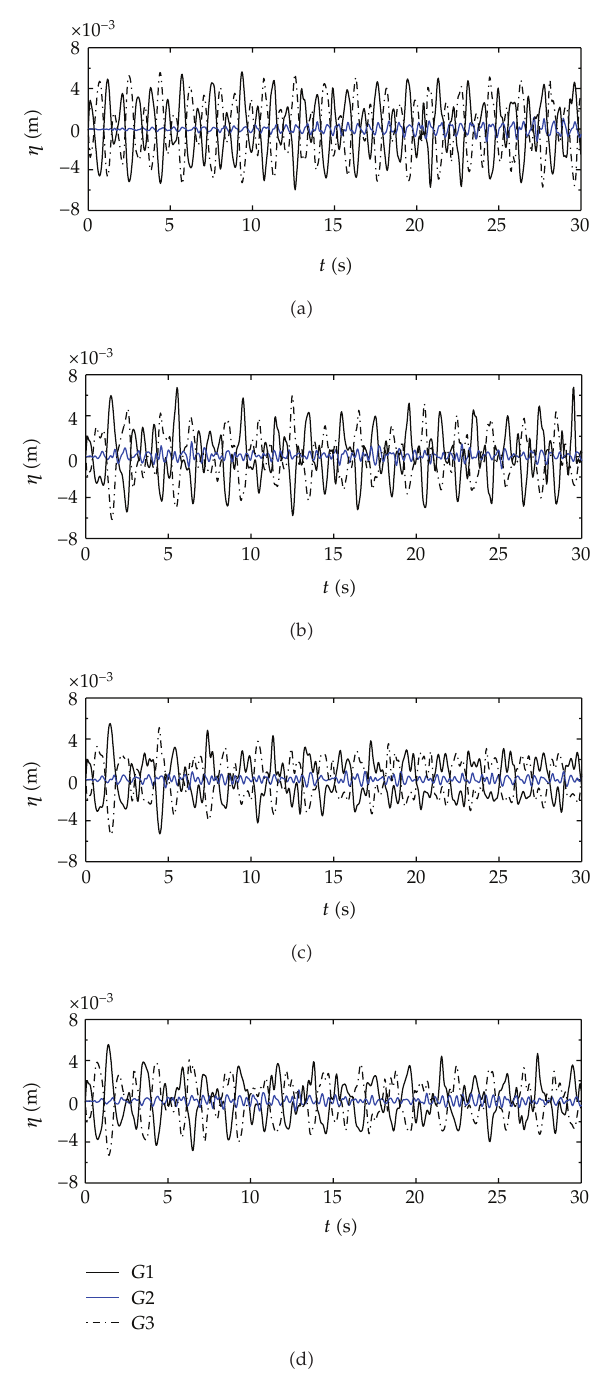
Figure 8: Comparisons of the free surface elevation at three wave gauges among the di ff erent ba ffl e arrangements under the excitation of ω (cid:9) π rad/s (cid:6)(cid:6) a (cid:7) without ba ffl e; (cid:6) b (cid:7) b (cid:9) 0mm; (cid:6) c (cid:7) b (cid:9) 40mm; (cid:6) d (cid:7) b (cid:9) 80mm (cid:7)